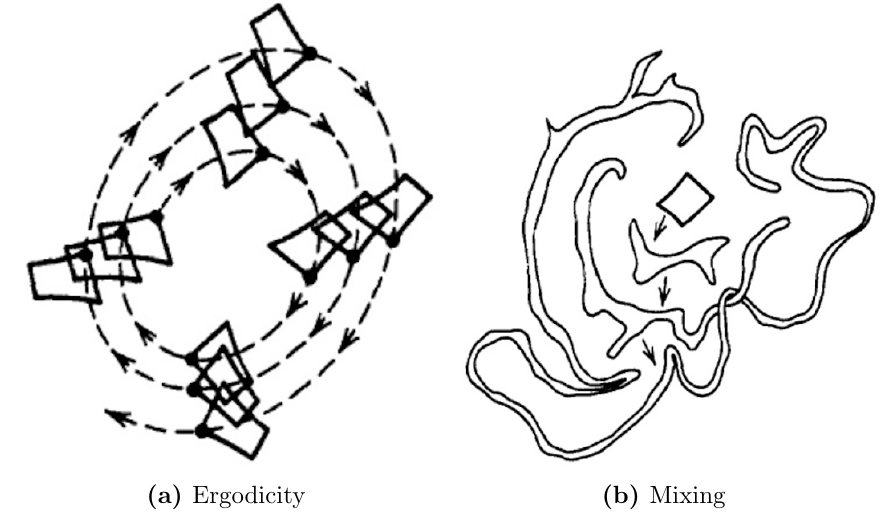
Figure 13. (a) Ergodicity: the shape of the initial sample only changes slightly but sweeps out the entire allowed region under time evolution, (b) Mixing: the initial sample spreads out and reaches in(cid:12)nitesimally close to all the points in the allowed region of the phase space. Figure adopted from [50,